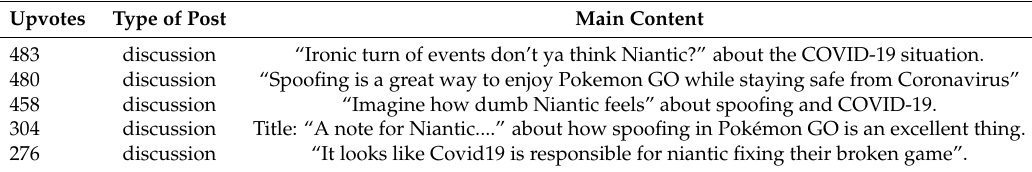
Table 6. TOP 5 upvoted comments on